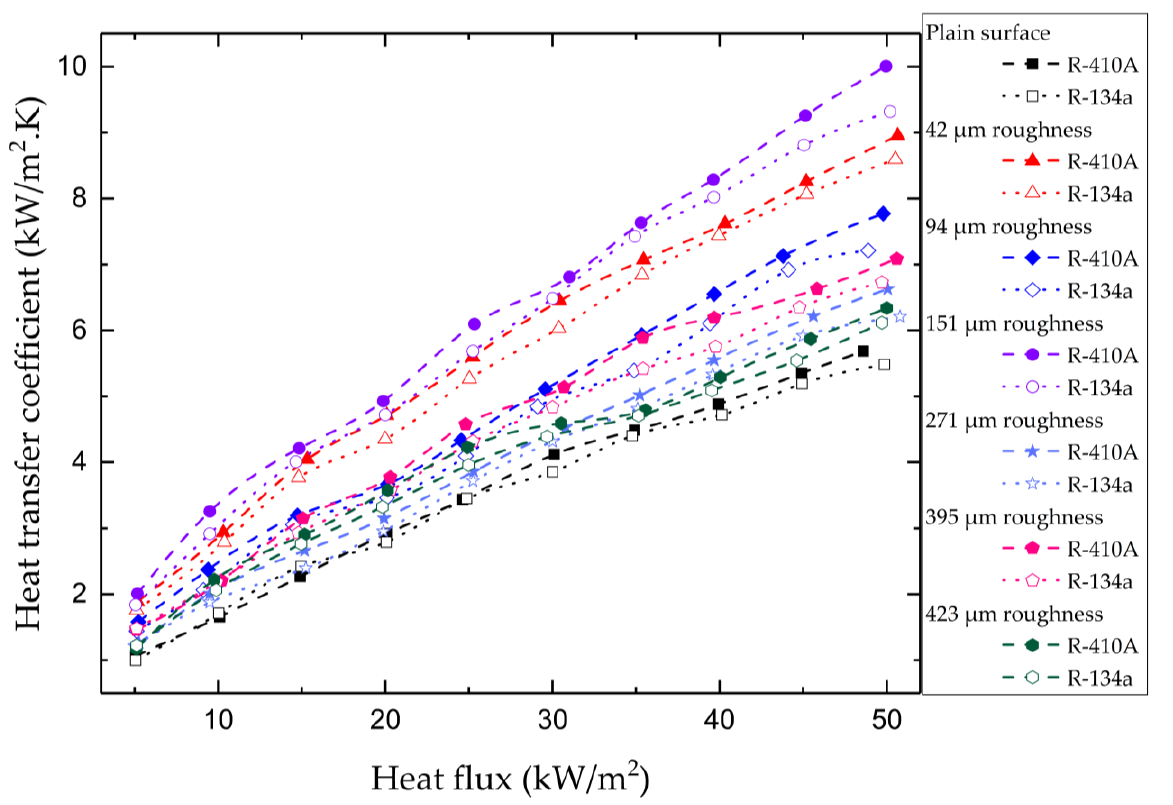
Figure 7. HTCs versus heat flux for seven types of coating [40] .